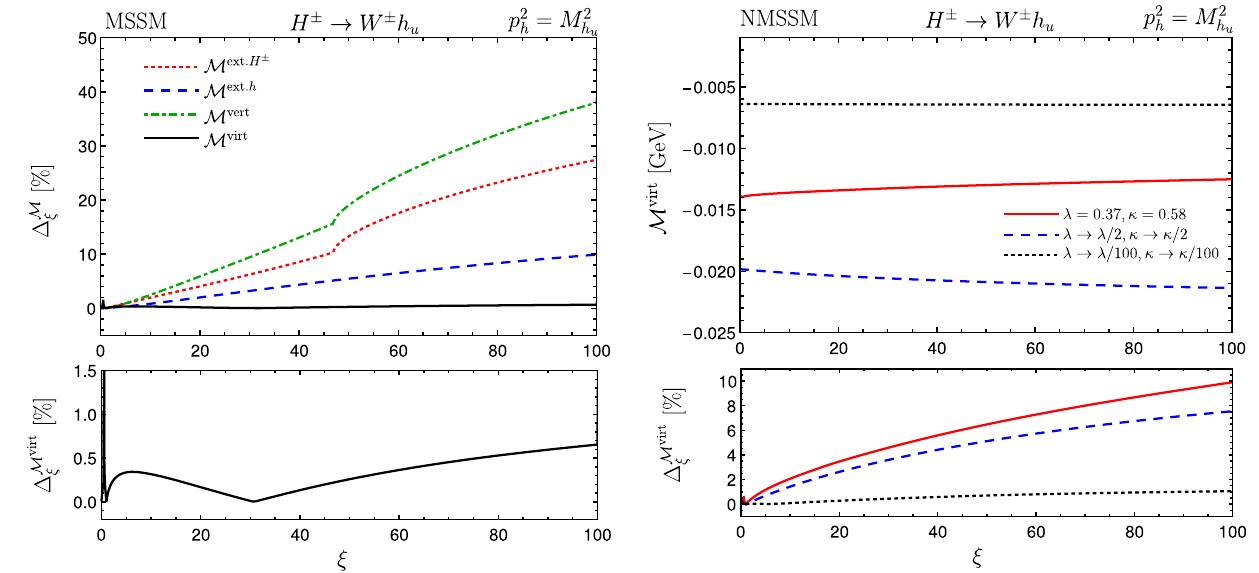
M virt as a function of ξ (upper) and its relative gauge dependence Fig. 9 Left: Gauge dependence of the virtual electroweak corrections to H ± → W ± h u in the MSSM-limit, using loop-corrected masses for (lower) for λ = 0 . 37, κ = 0 . 58 (parameter point P1, red/full lines) = M 2 and their variation to half their values (blue/dashed lines) and to λ/ 100, the external neutral Higgs boson p 2 calculated in general R ξ h h u κ/ 100 (black/dotted lines) gauge. The color and line code is the same as in Fig.8. Lower panel: Gauge dependence of M virt with the vertical axis zoomed-in Right: